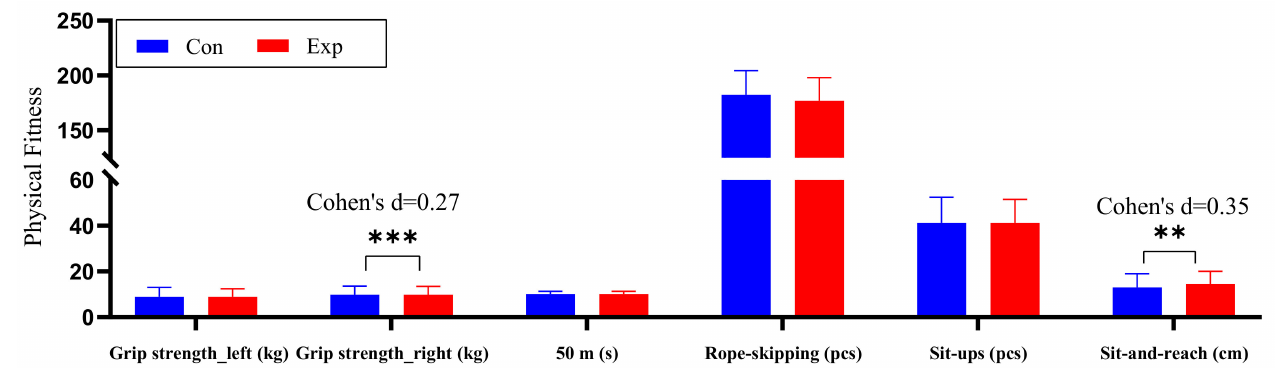
Figure 6. Descriptive statistics, between-group variations of means of physical fitness. **: p < 0.01; ***: p < 0.001.